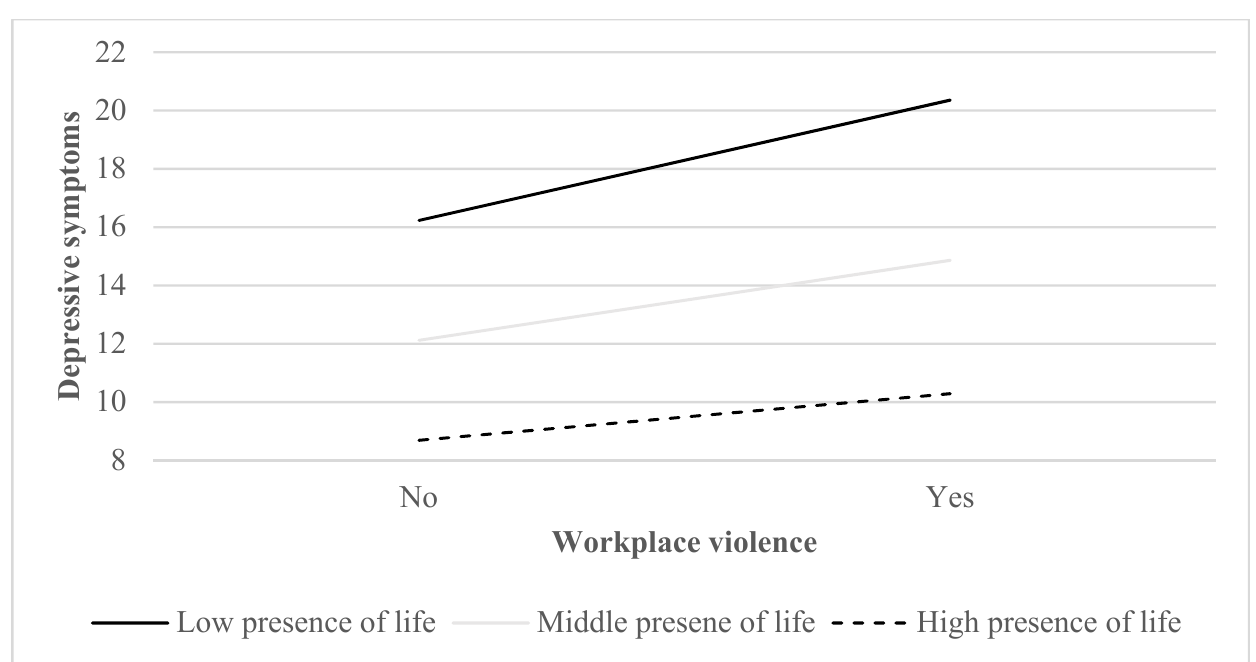
Figure 1. Meaning in life moderated the relationship between workplace violence and depressive symptoms among primary health care professionals.